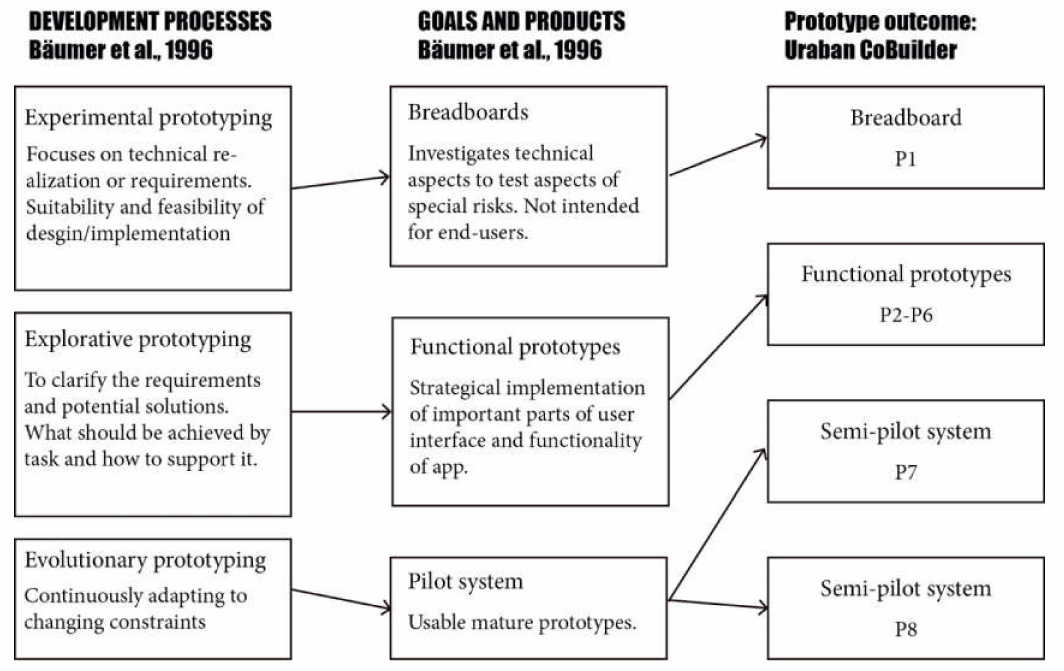
Figure 2. Applied processes of iterative prototyping for the outdoor MAR (Urban CoBuilder). Adapted from [59] (pp. 532–533). P =